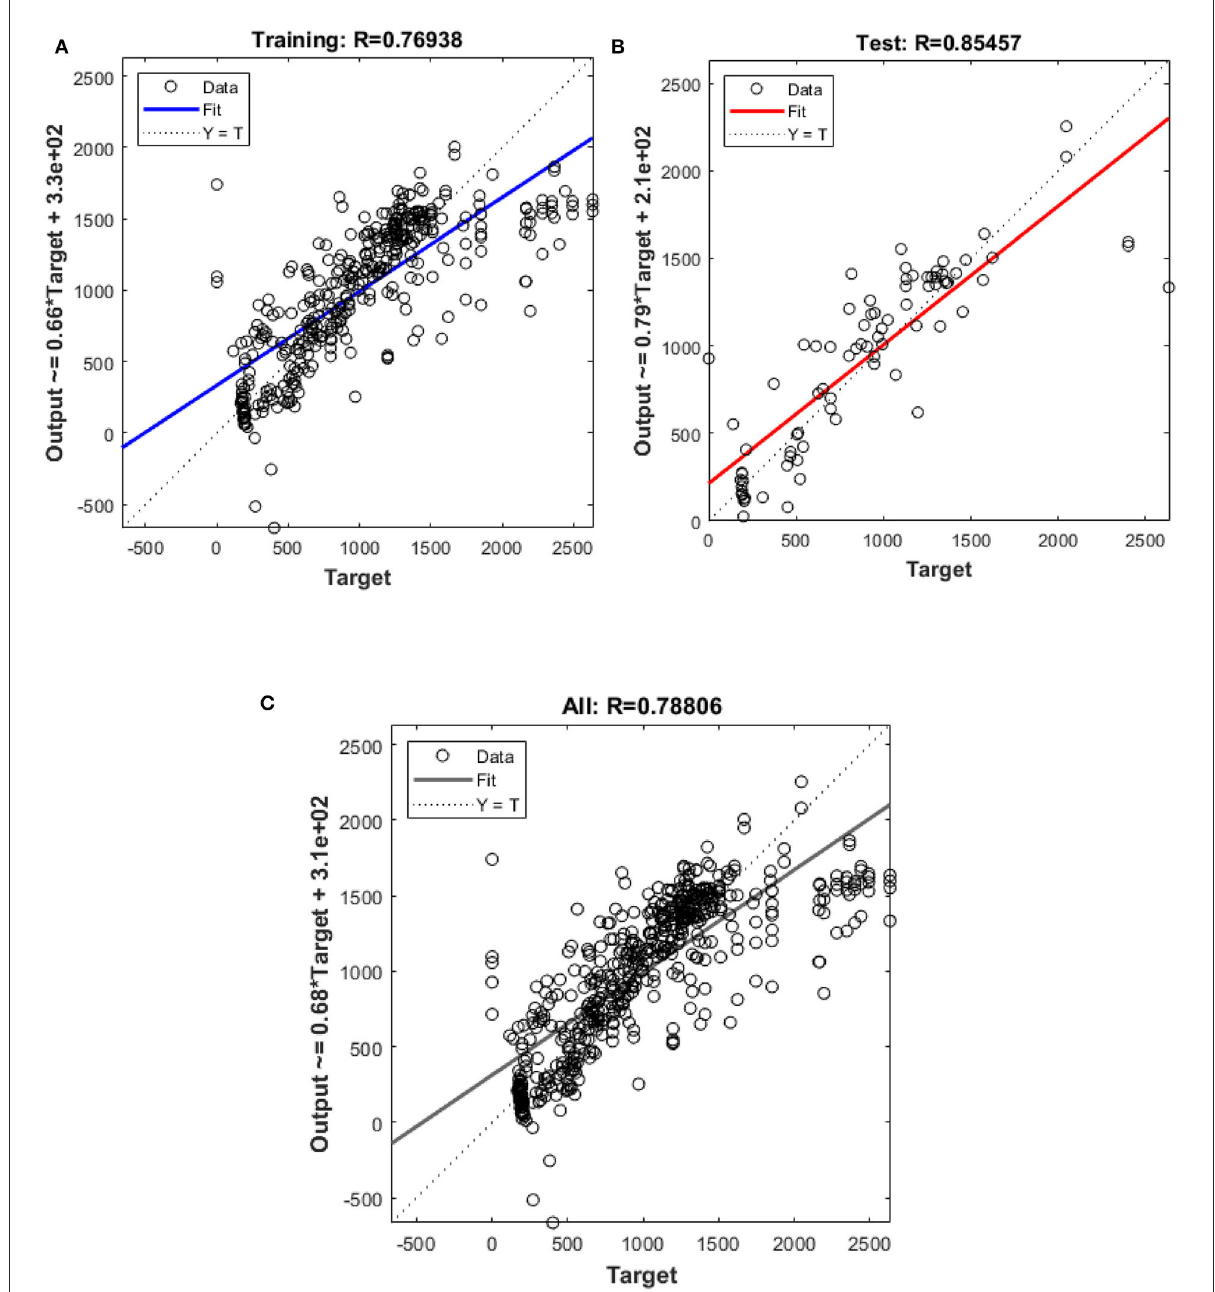
FIGURE5 Outputs of (A) Training and (B) test (C) all data sets by Scaled-Conjugate Gradient algorithm as a function of actual (target) DLP.